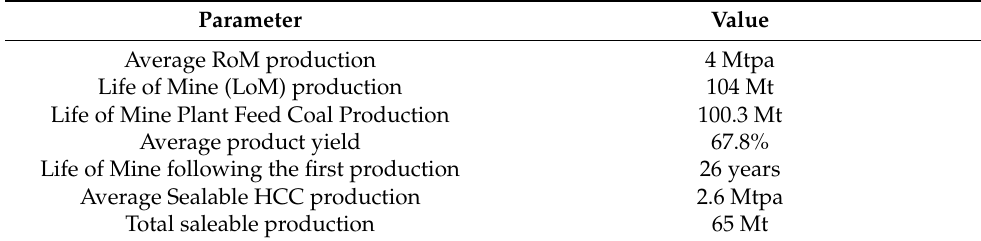
Table 3. Assumed production parameter of D˛ebie´nsko project